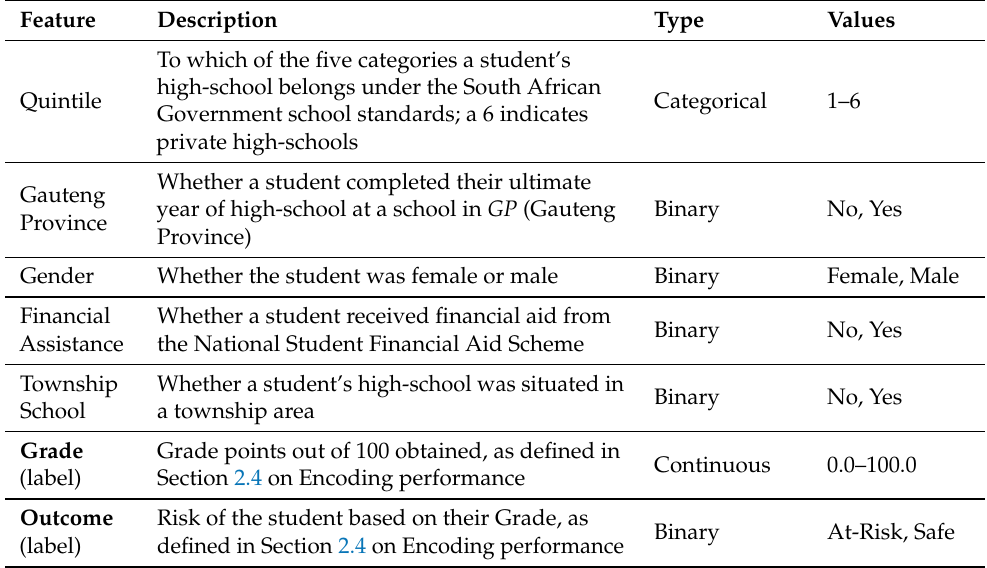
Table 3. Background data features and labels after